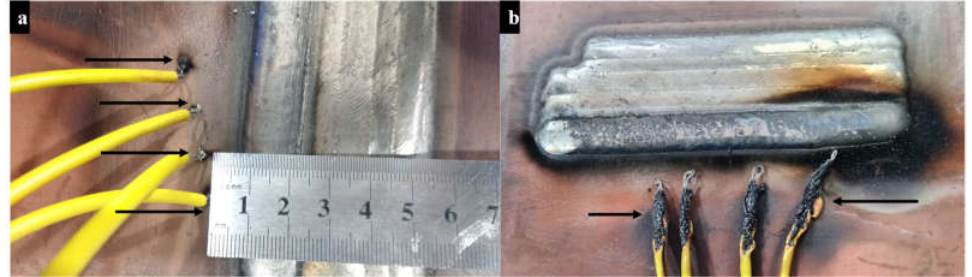
Figure 2. Assembly of thermocouples before ( a ) and after ( b ) welding.